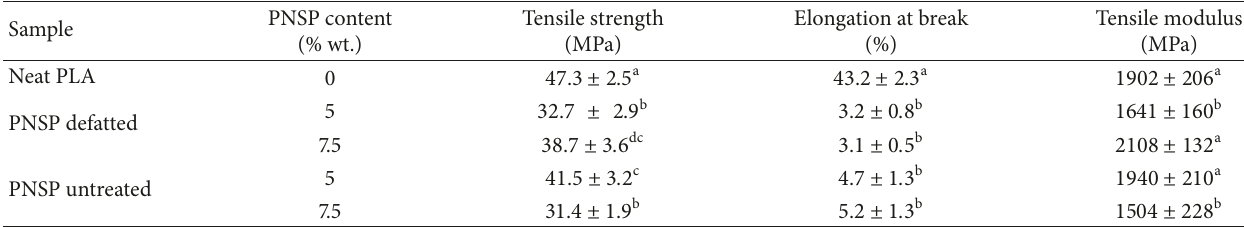
Table 2: Mechanical parameters from tensile tests of the PLA-PNSP biocomposites ∗ .